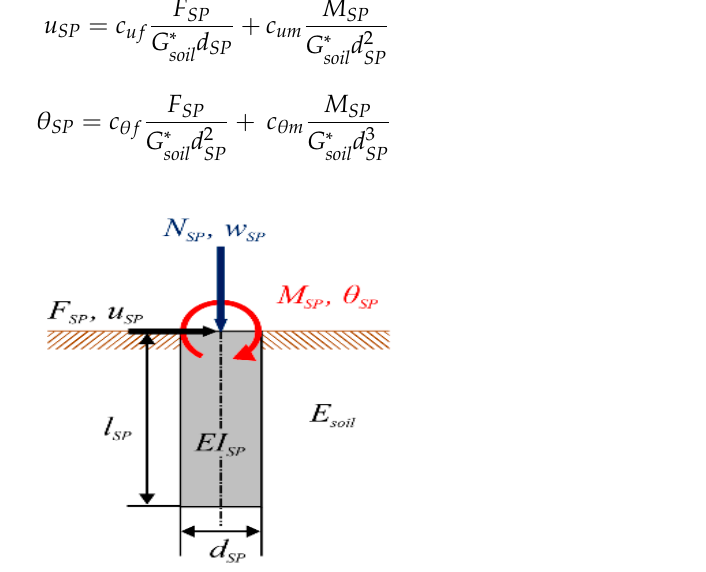
Figure 7. Simplified analysis model of a single suction pile.